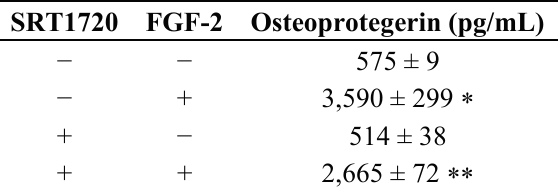
Table 1. The effect of SRT1720 on the FGF-2-stimulated osteoprotegerin release in MC3T3- E1 cells. The cultured cells were pretreated with 10 µM of SRT1720 or vehicle for 60 min and then stimulated by 30 ng/mL of FGF-2 or vehicle for 48 h. Osteoprotegerin concentrations of the culture medium were determined by ELISA. Each value represents the mean ± SEM of triplicate determinations from three independent cell preparations.  p < 0.05, compared to the value of control. ** p < 0.05, compared to the value of FGF-2 alone. SRT1720 FGF-2 Osteoprotegerin (pg/mL) − − 575 ± 9 − + 3,590 ± 299  + − 514 ± 38 + + 2,665 ± 72 